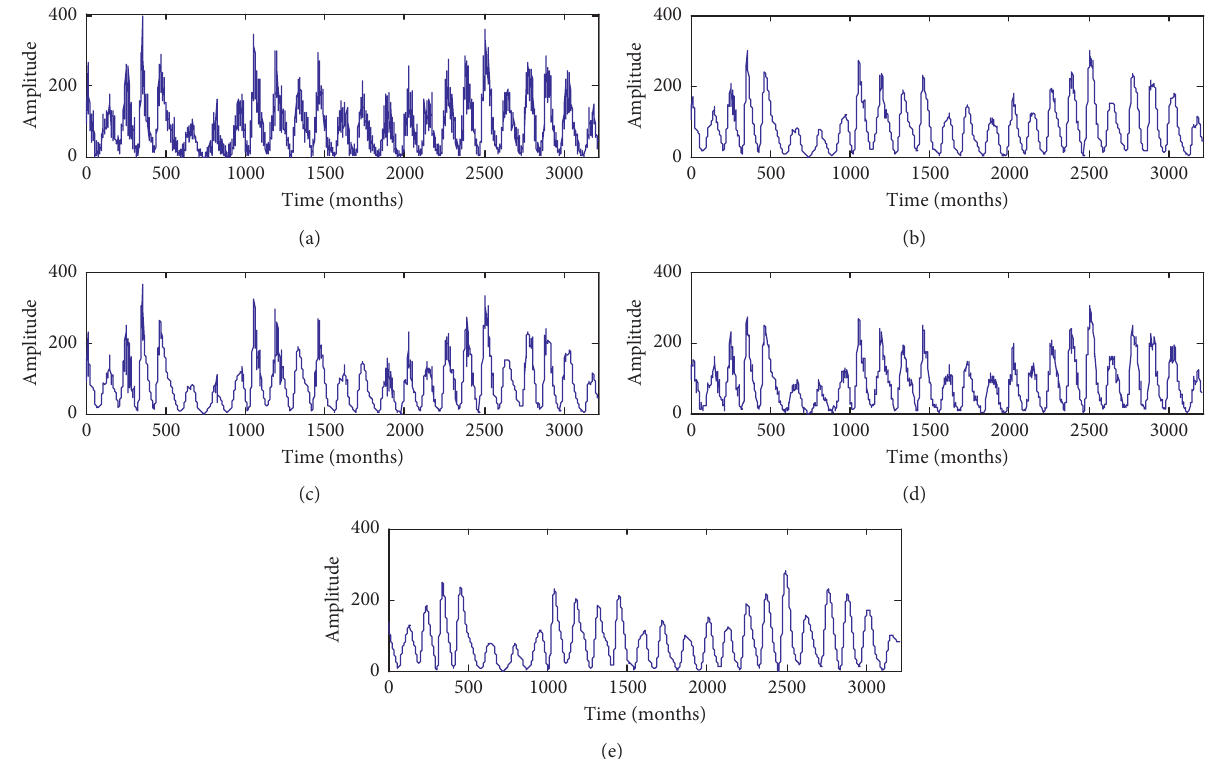
Figure 10: (a) Observation data of monthly mean number of sunspot plane. (b) The noise reduction result by EMD thresholding. (c) The noise reduction result by wavelet thresholding. (d) The noise reduction result by AMMF. (e) The noise reduction result by